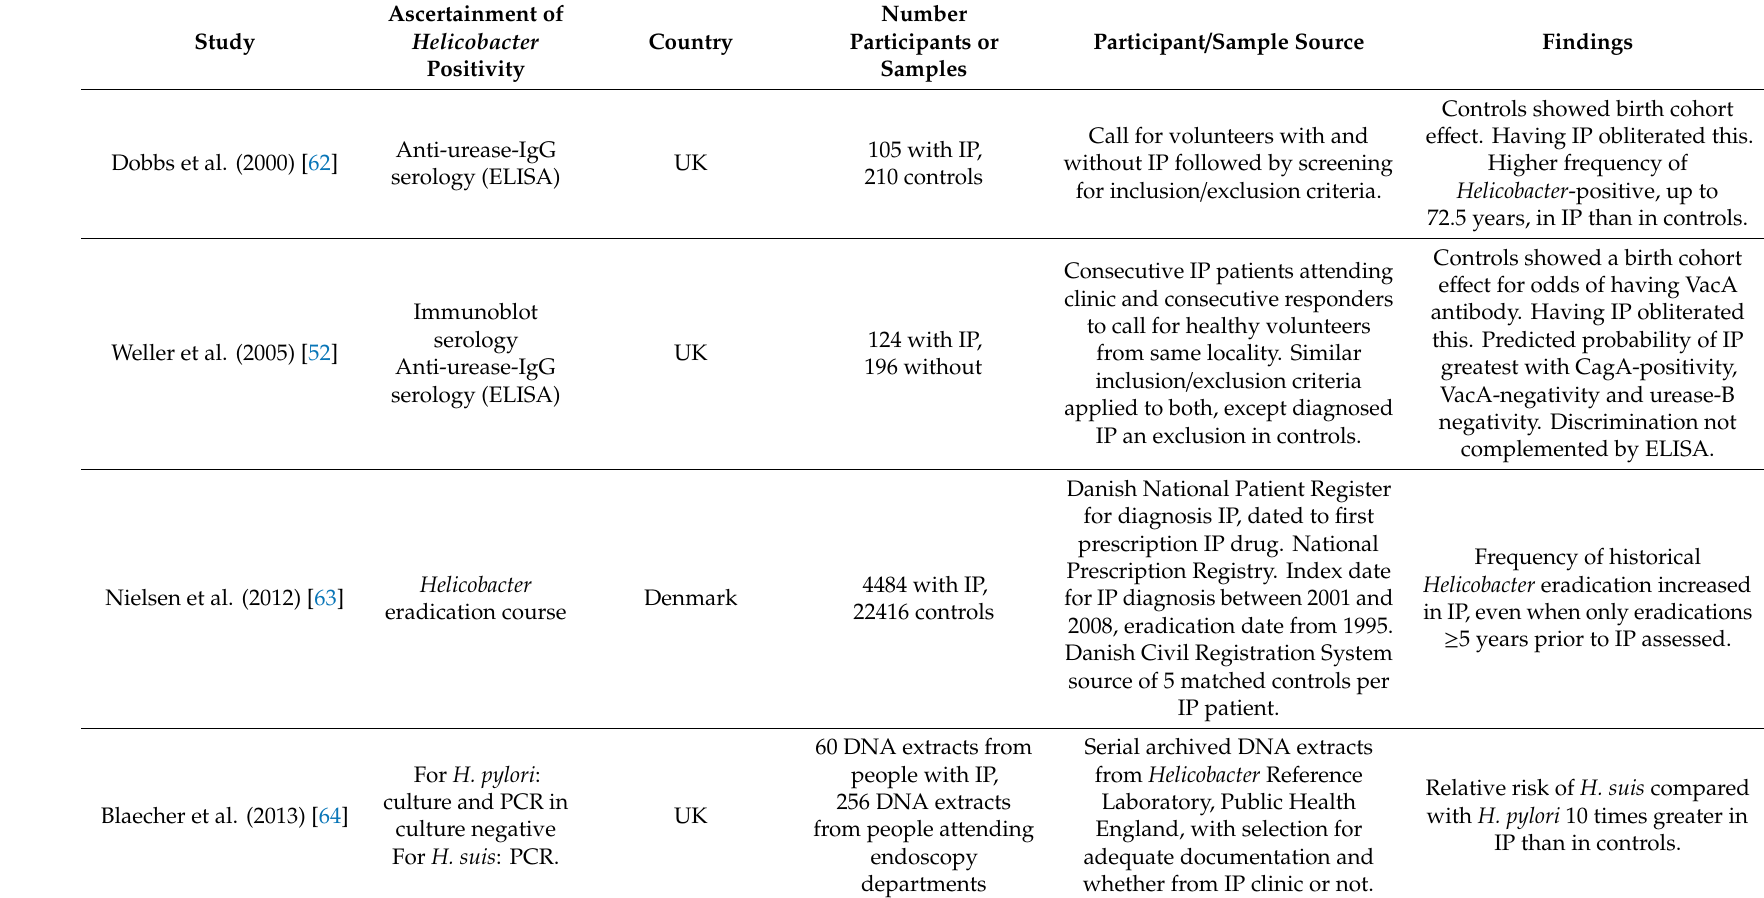
Table 5. Observational studies of comparative frequency of associated Helicobacter and idiopathic parkinsonism and its age